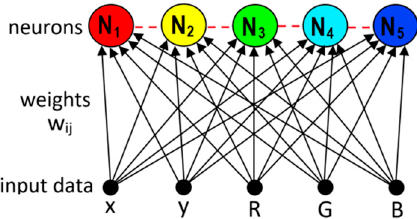
Table 1. Training parameters.